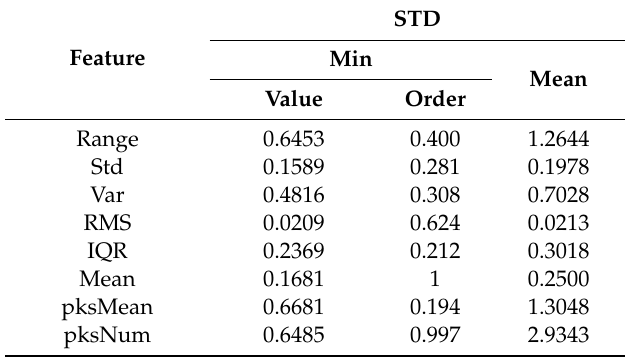
Table 4. Mean and min of standard deviation of each feature of dwstairs.